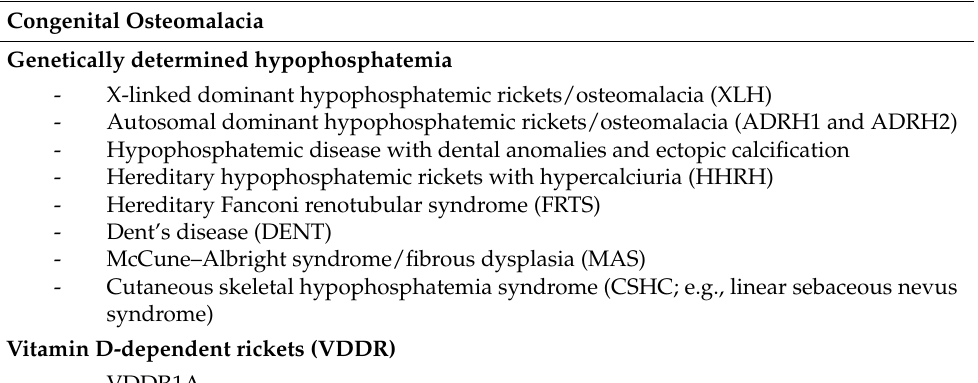
1C—Classification of osteomalacia based on the